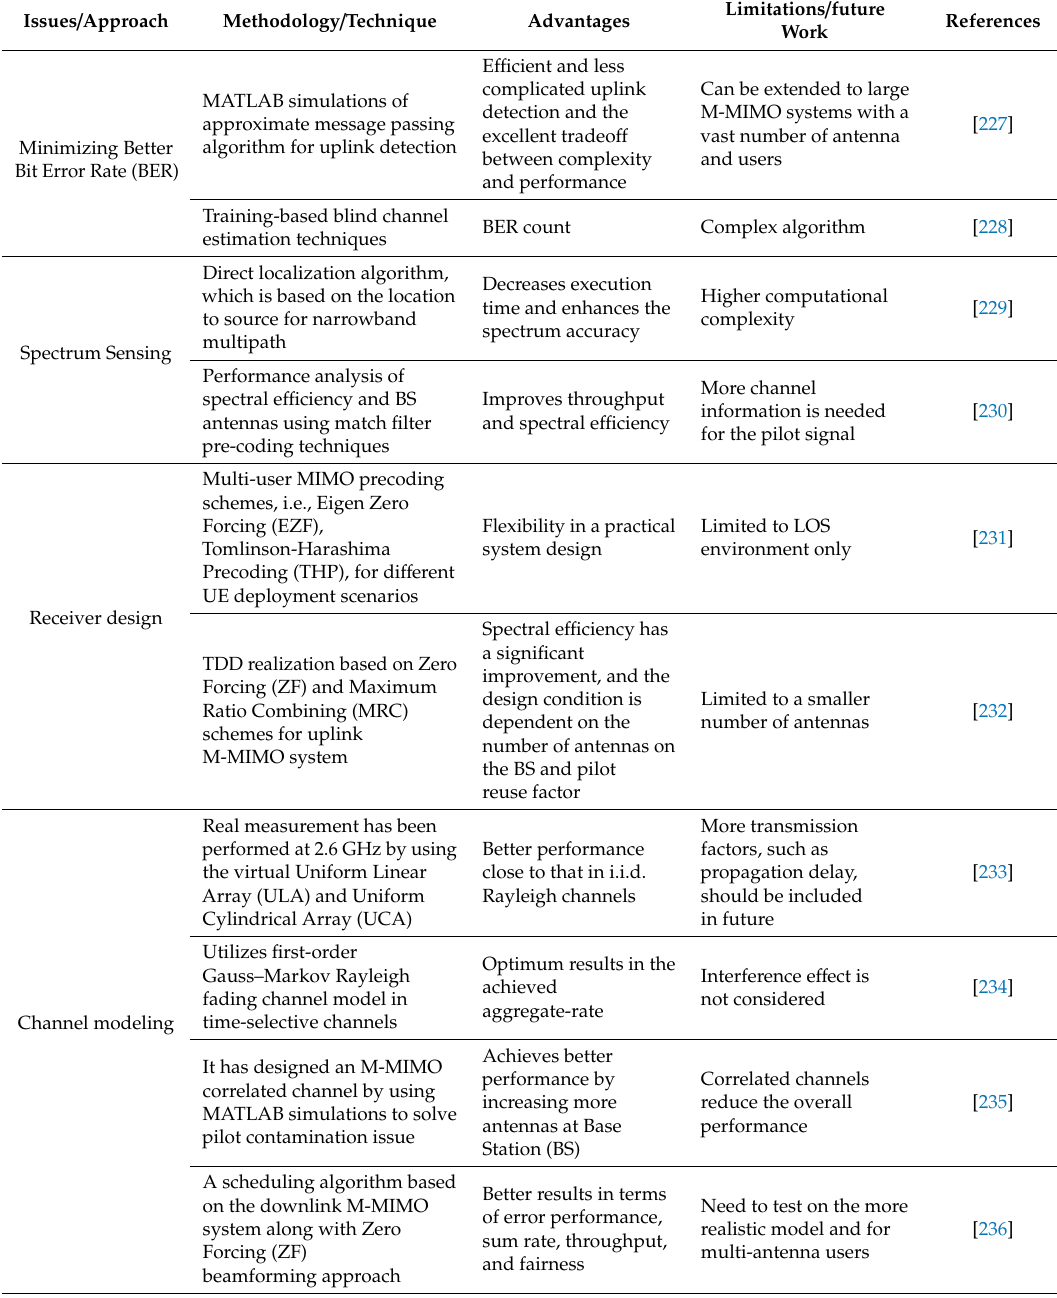
Table 5. Summary of the related work for